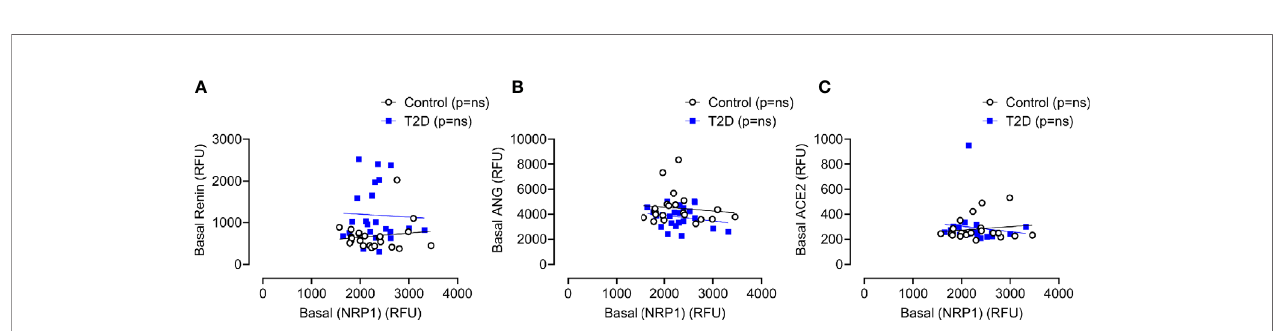
FIGURE 3 | Correlation of plasma levels of soluble NRP1 (sNRP1) with basal levels of renin angiotensinogen system (RAS) proteins. Correlation of soluble NRP1 (sNRP1) with Renin (A) , angiotensinogen (ANG) (B) and angiotensin-converting enzyme 2 (ACE2) (C) . No correlation of sNRP1 with these RAS proteins was found in either T2D or control subjects. Control subjects, open black circles; T2D subjects, solid blue squares; ns, not signi fi cant.